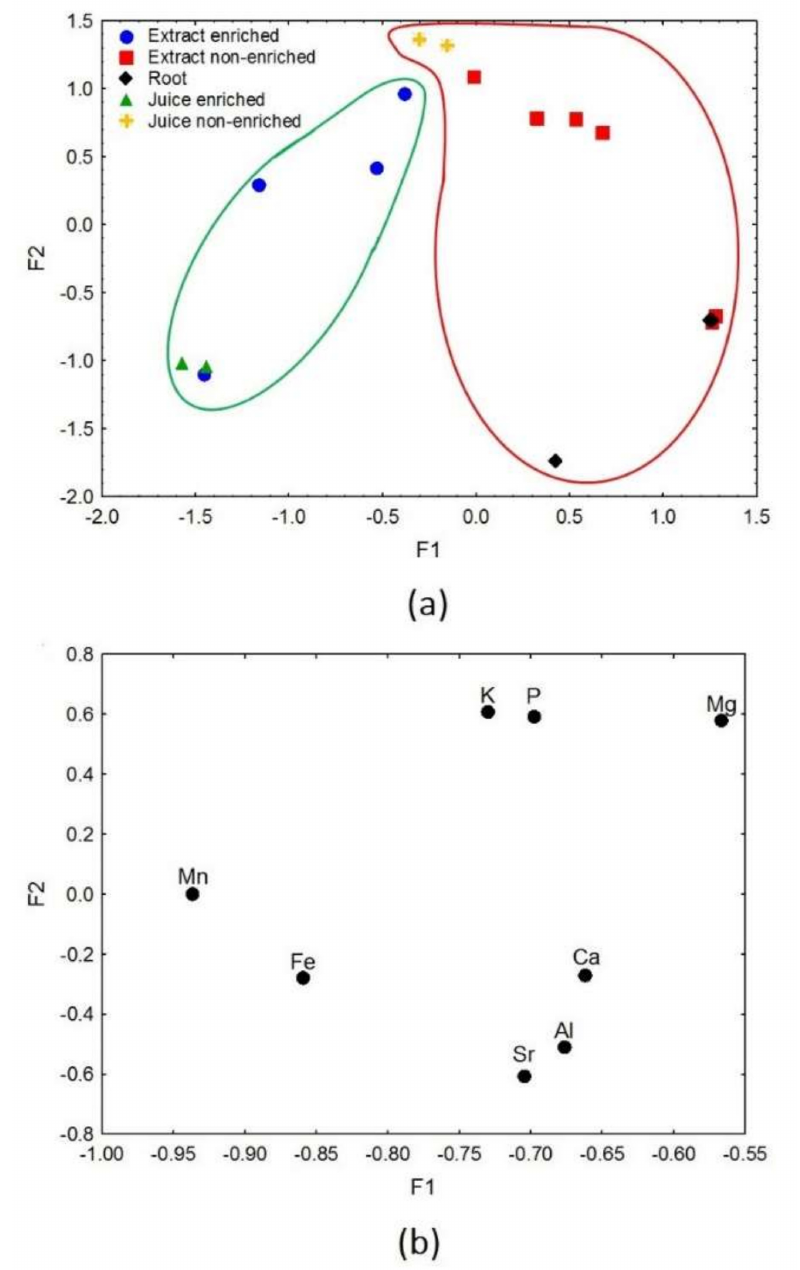
Figure 6. ( a ) Scatter plot of objects samples of two factors for the dietary supplements which were categorized accordingly: Fe-enriched (green line) and non-enriched (red line) products. ( b ) Scatter plot of loading for elements in all the analysed